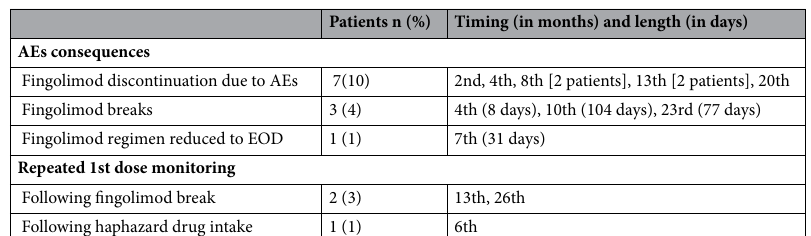
Table 3. Adverse event consequences and repeated first-dose monitoring (n = 67 patients). AEs: adverse events; EOD: every other day; n: number.